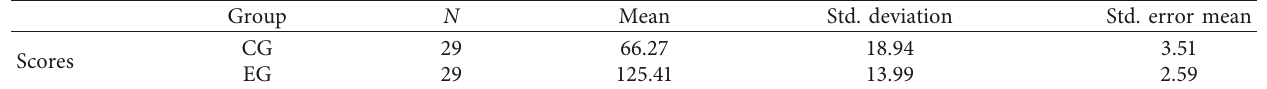
Table 3: Descriptive statistics (anxiety post-test of both groups).